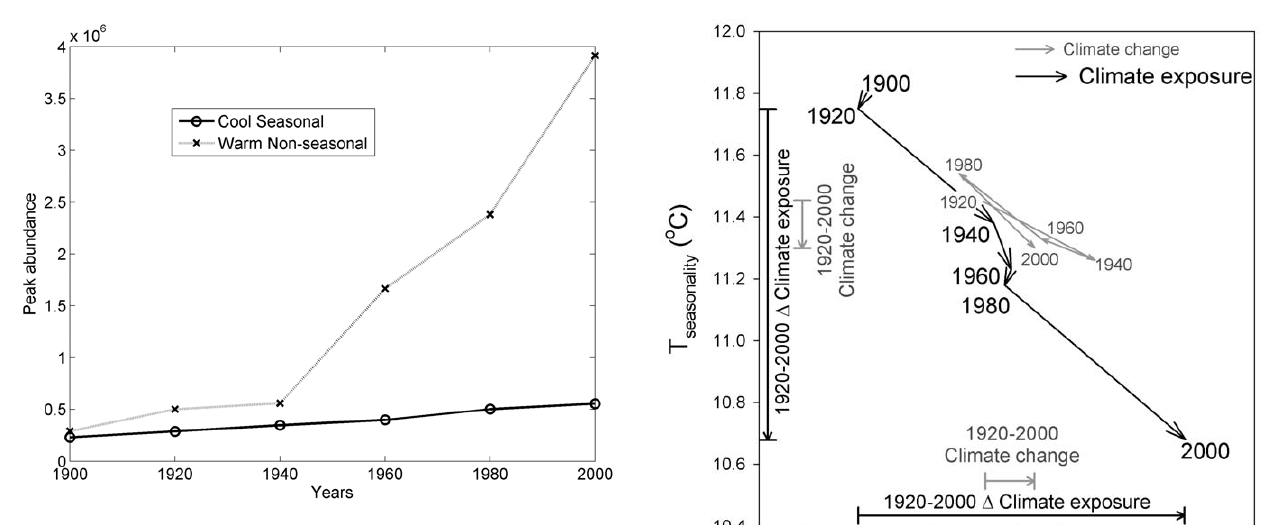
Figure 3. Population abundance of the two population peaks of the U.S. thermal niche during the 20 th century.